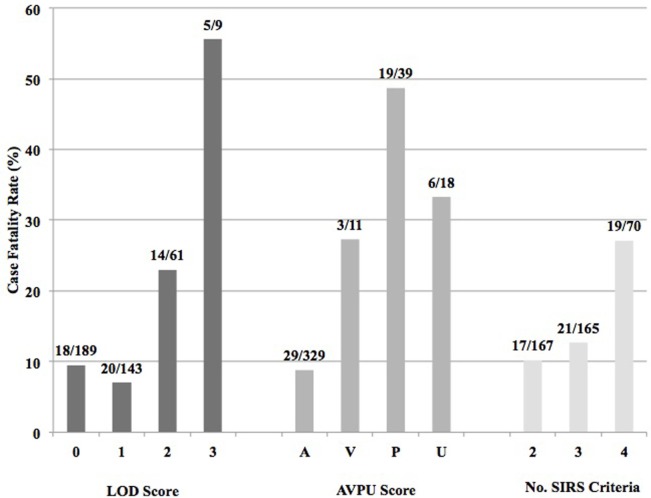
Case fatality rates by Lambaréné Organ Dysfunction Score, best response by the Alert-Verbal-Painful-Unresponsive (AVPU) score, and number of SIRS criteria present on admission.